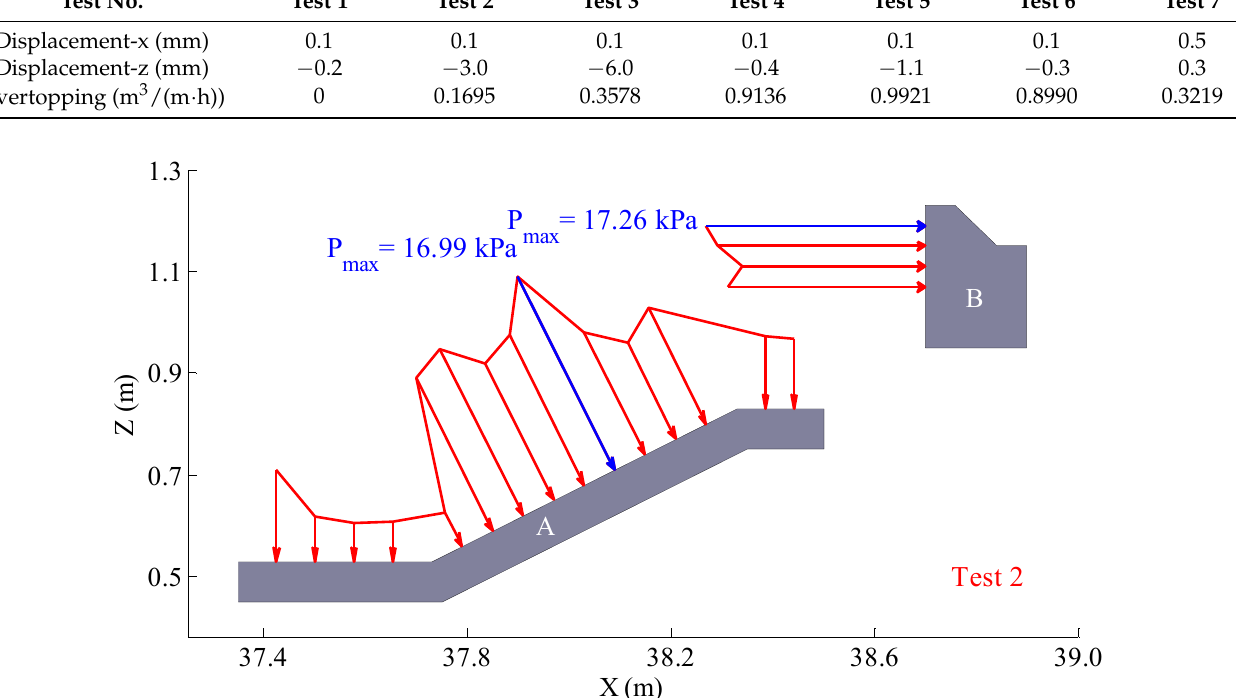
Figure 17. Distribution of the maximum wave impact on the surface of the revetment breakwater under regular wave loading in Test 2.